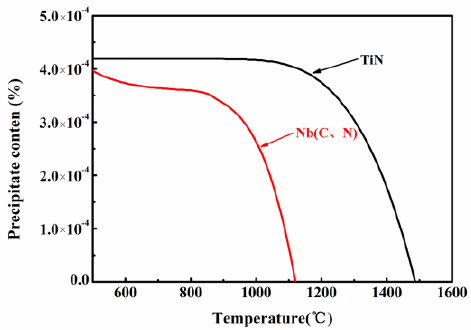
Figure 7. Thermo-Calc software calculates the precipitation order and amount of Sb + Sn steel.